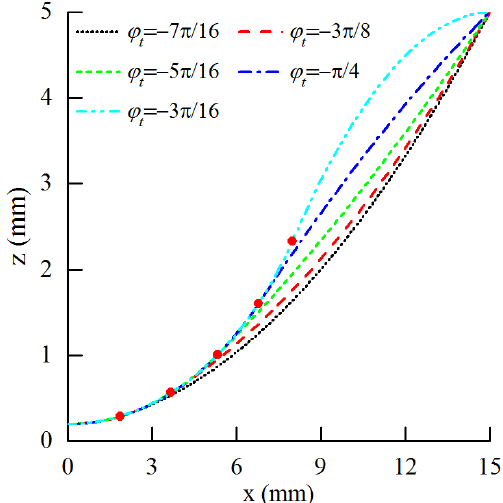
Figure 4. Notch shapes with different e ( ϕ t = − π from 12 to